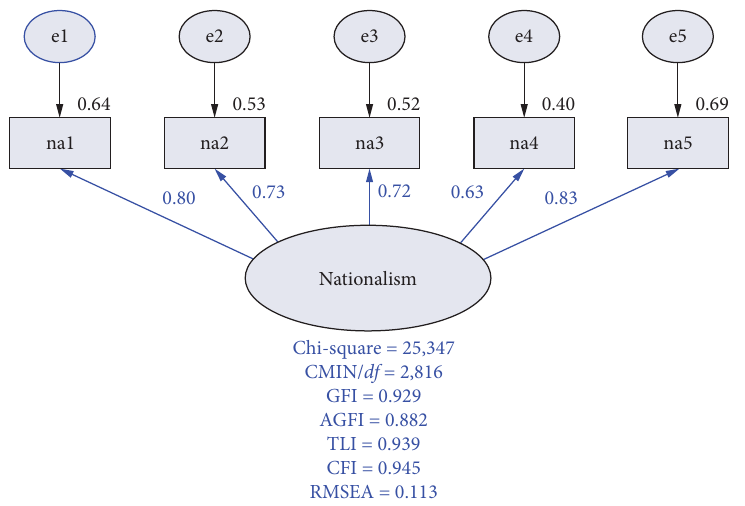
F IGURE 1: Diagram and output of AMOS 24 application for nationalism